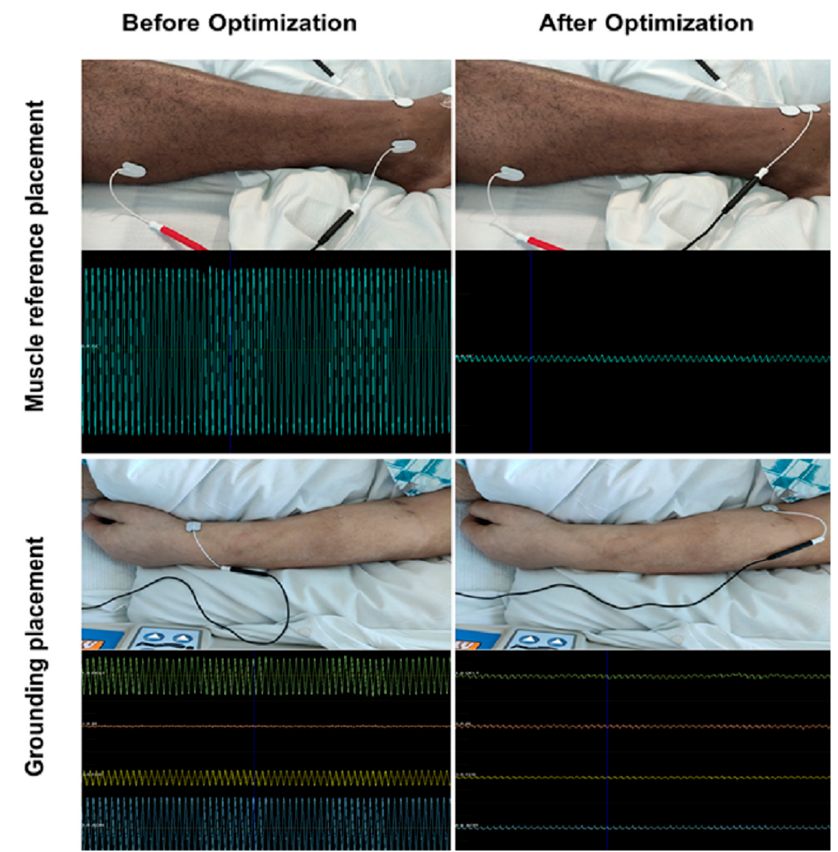
Figure 3. Electromyography (EMG) noise optimization . This figure illustrates the effect of electrode placement on noise level. All placement spots are common for neutral electrode placement, yet significant differences can be observed. At bedside, optimal positioning often requires testing of different spots until an adequate noise level is achieved. EMG scales are equal within the same row.